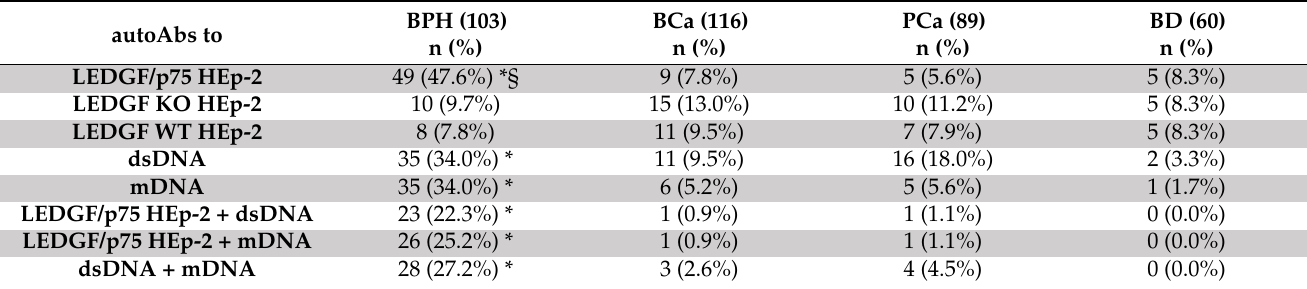
Table 1. Qualitative autoantibody (autoAb) results from patients with bladder cancer (BCa), benign prostatic hyperplasia (BPH), and prostate cancer (PCa), as well as blood doors (BD). IgG autoAbs against HEp-2 wild-type (WT), LEDGF/p75 knock-out (KO), and LEDGF/p75 over-expressing (OE) HEp-2 cells, double-stranded (dsDNA), and mitochondrial DNA (mDNA) were ascertained by indirect immunofluo- rescence assay, line immunoassay, and Crithidia luciliae immunofluorescence test,